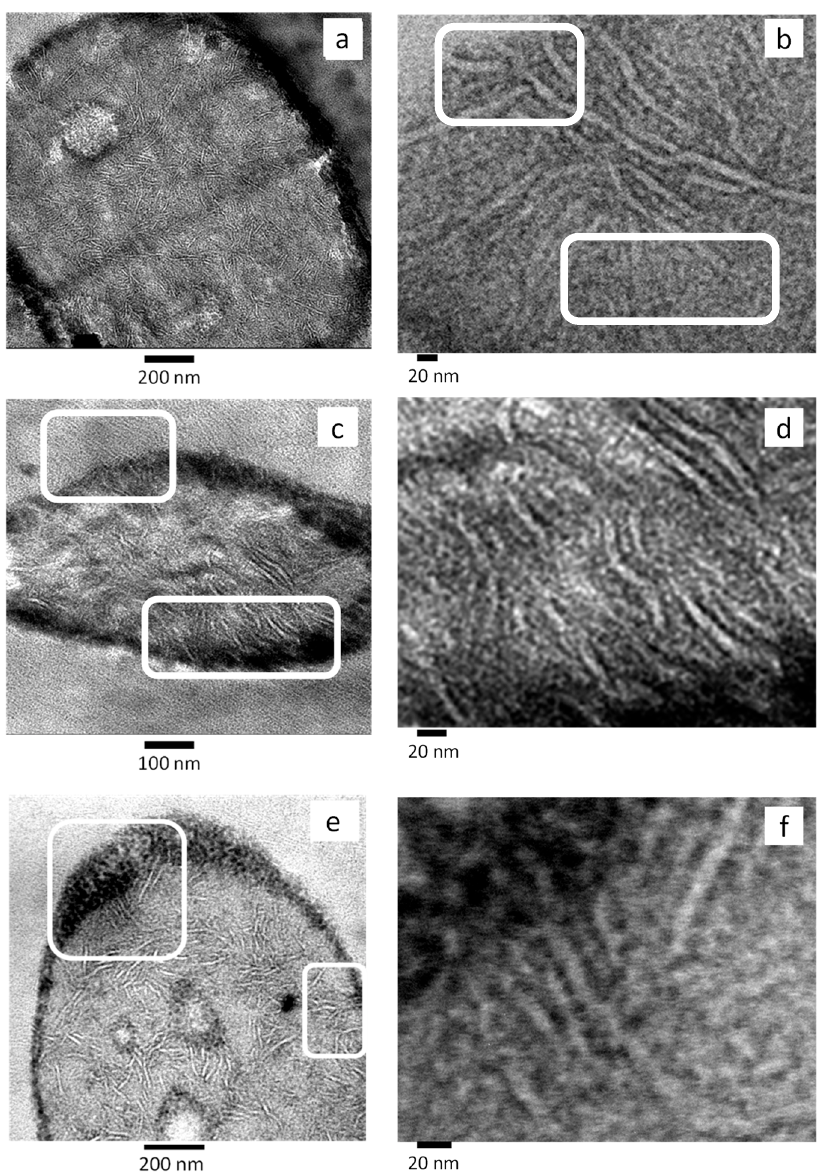
Figure 11. TEM images of 80rPP / 20rPET / 12% TiO 2 PBNANOs containing: ( a , b ) hydrophilic TiO 2 (hphi); ( c , d ) hydrophobic TiO 2 (hpho); ( e ) and ( f ) hydrophobically modified TiO 2 (hphoM).